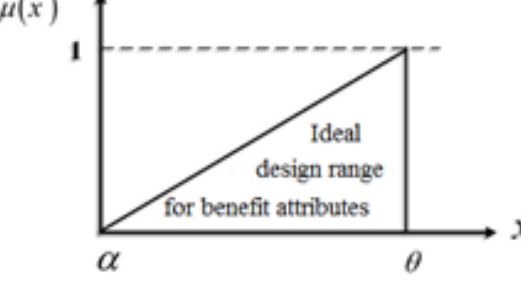
Figure 4. Ideal design range for benefit